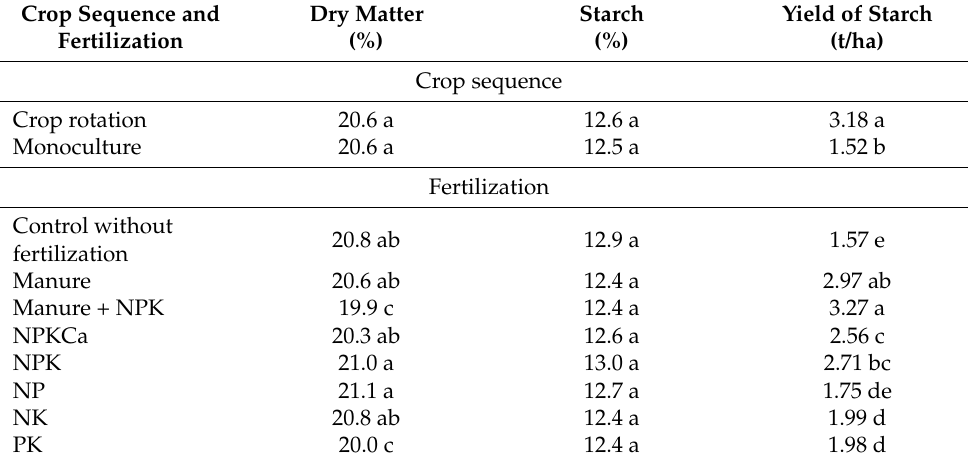
Table 3. Content of dry matter and starch and yield of starch of potato tubers (mean of 2007–2013).